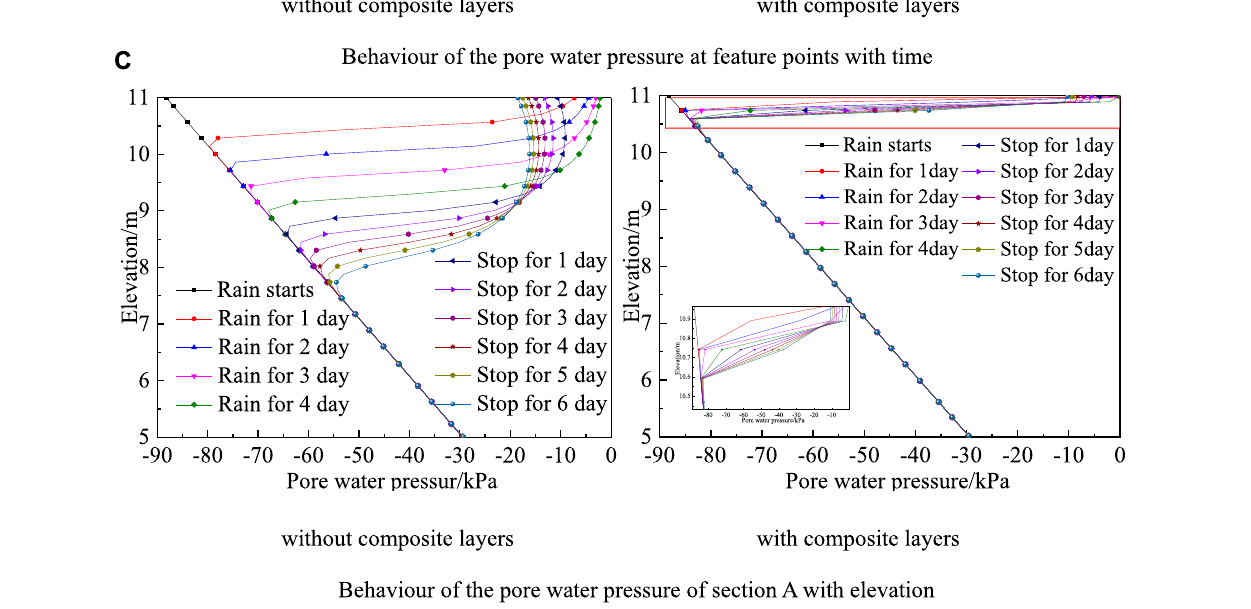
FIGURE 11 | Behaviour of the pore water pressure of the silt subgrade slope with time and elevation.without composite layers with composite layers. (A) Distribution of pore water pressure of the silt subgrade slope. (B) Behaviour of the pore water. pressure at feature points with time. (C) Behaviour of the pore water pressure of section A with elevation